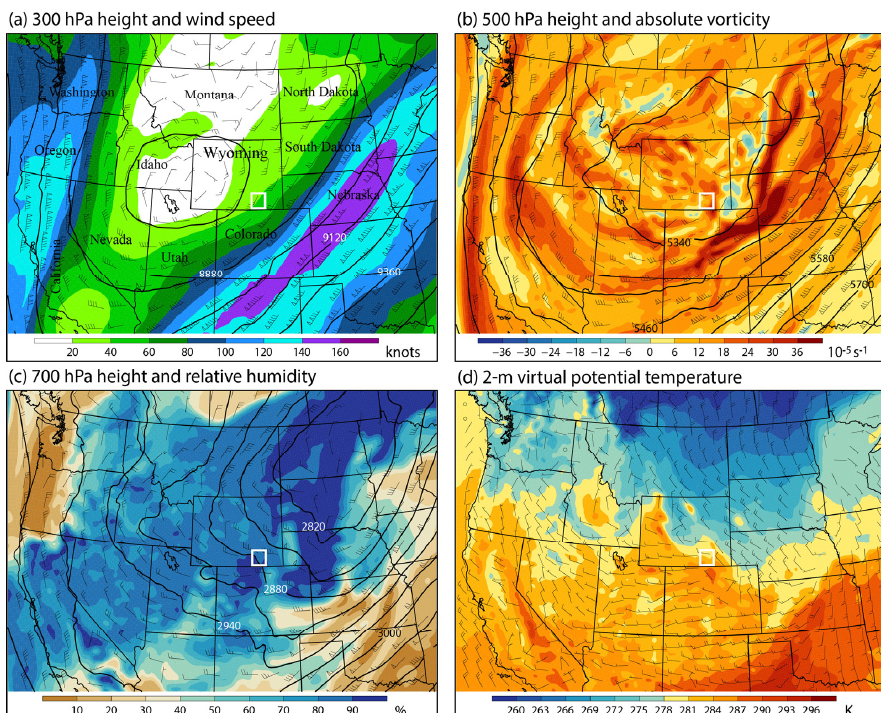
Figure 2. Synoptic condition from the 12 km NAM data at 0000 UTC on 12 January 2013. Wind barbs (full barb = 10 knots) are shown at each level, including at the surface (10 m) in ( d ). The white box in each panel shows the location of the Medicine Bow Mountains.